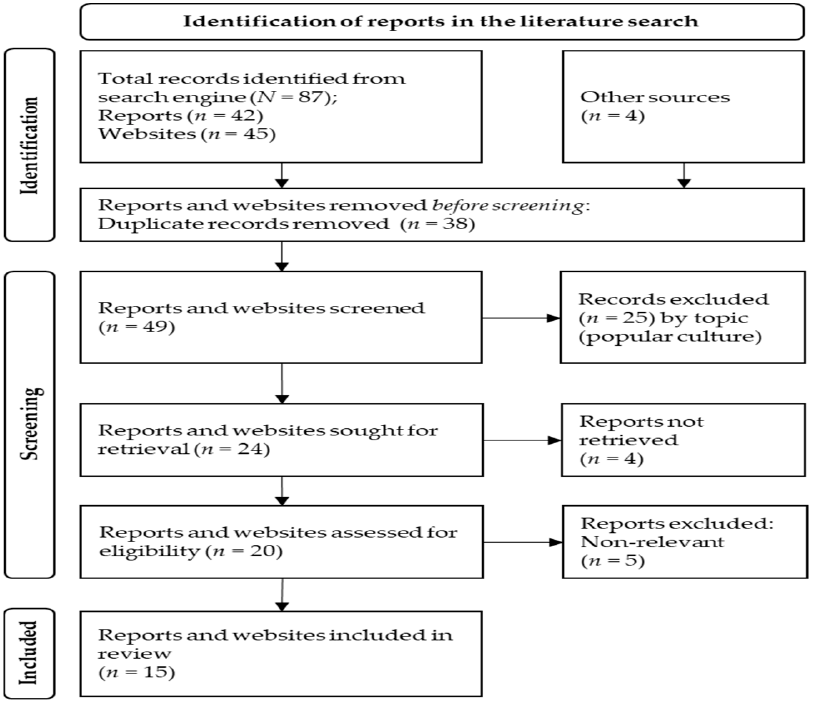
Figure 1. Flowchart for the literature review.